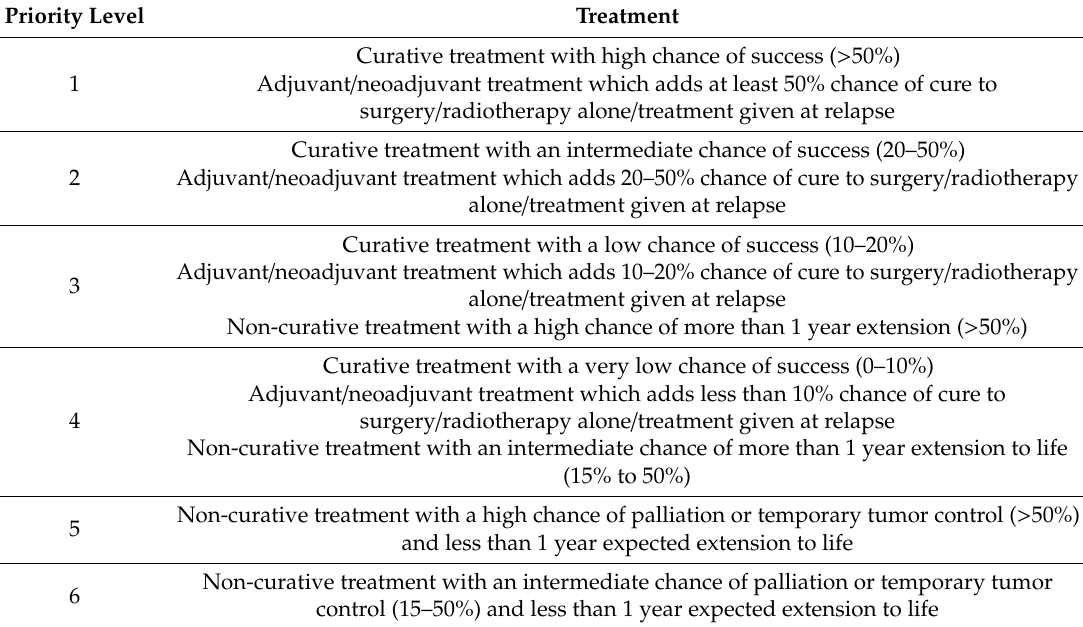
Table 3. Prioritizing systemic anticancer treatments (extracted and adapted from National Health System England’s clinical guide for the management of non-coronavirus patients requiring acute treatment: cancer